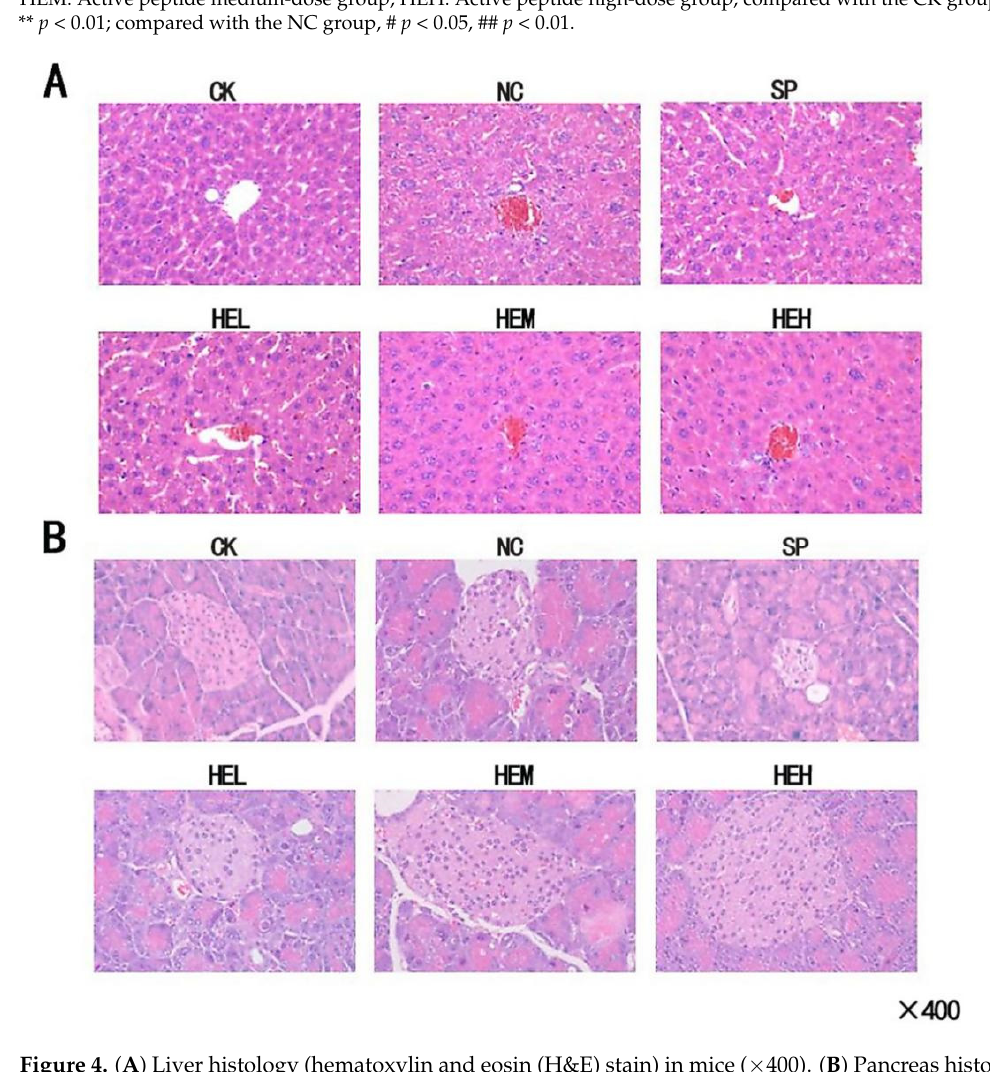
Figure 4. ( A ) Liver histology (hematoxylin and eosin (H&E) stain) in mice (×400). ( B ) Pancreas his- tology (H&E stain) in mice (×400). CK: Blank control group; NC: Model control group; PC: Sitagliptin group; HEL: Active peptide low-dose group; HEM: Active peptide medium-dose group; HEH: Active peptide high-dose group.